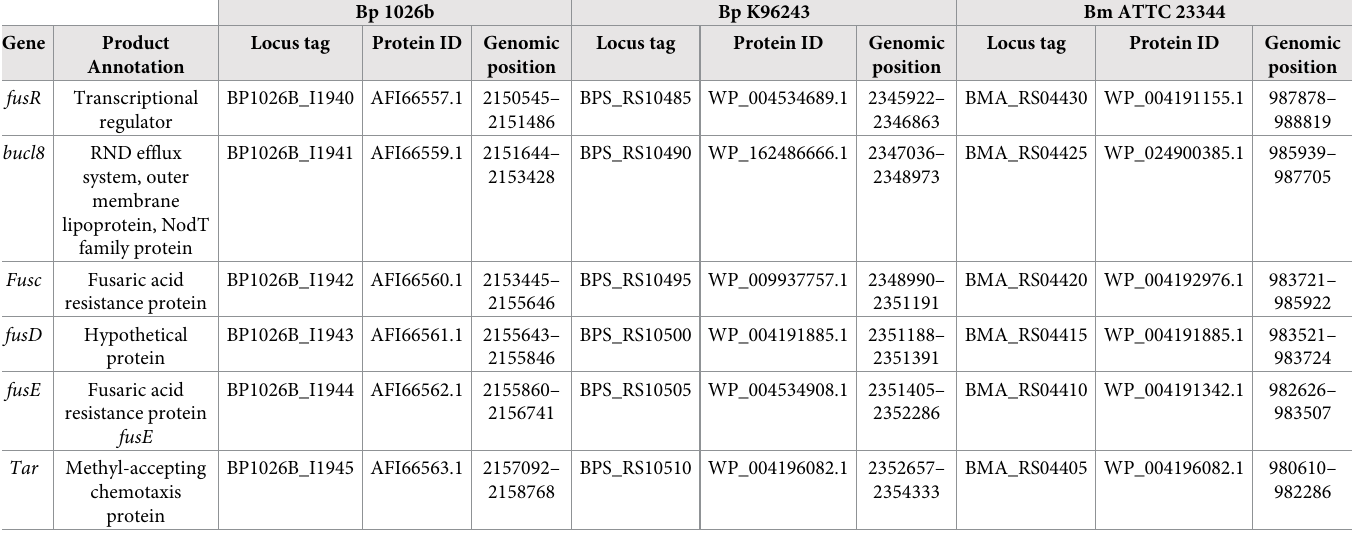
Table 3. Genes and associated identification numbers of bucl8